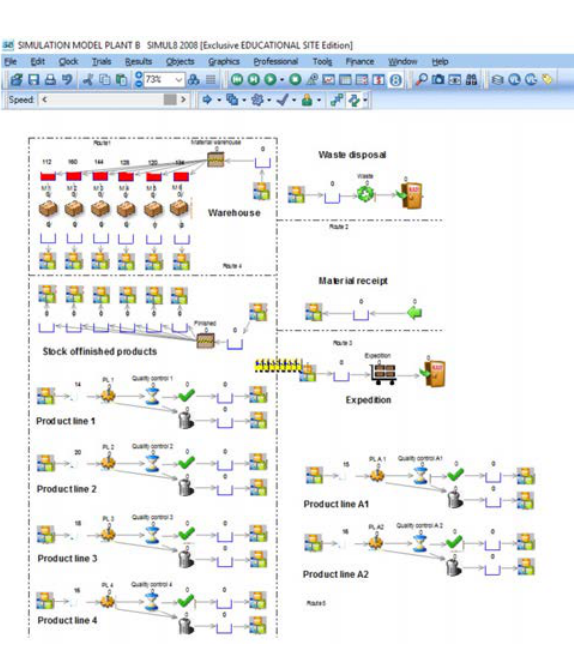
Figure 2: Conceptual model of Plant B – modified solution (Options 2 and 3).